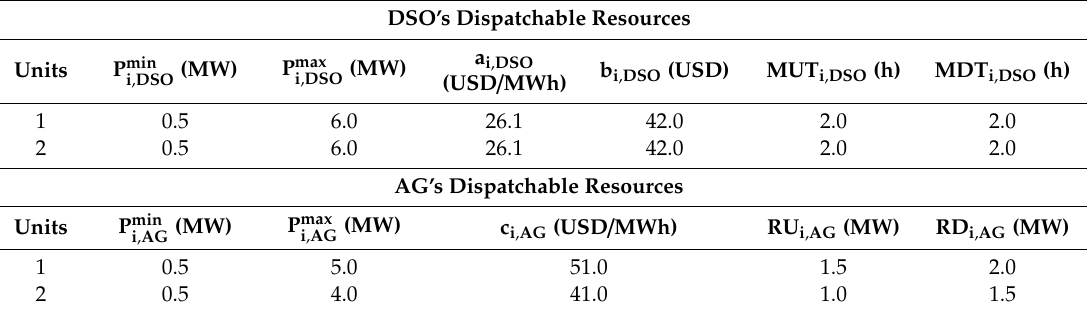
Table 4. Input data of dispatchable units.